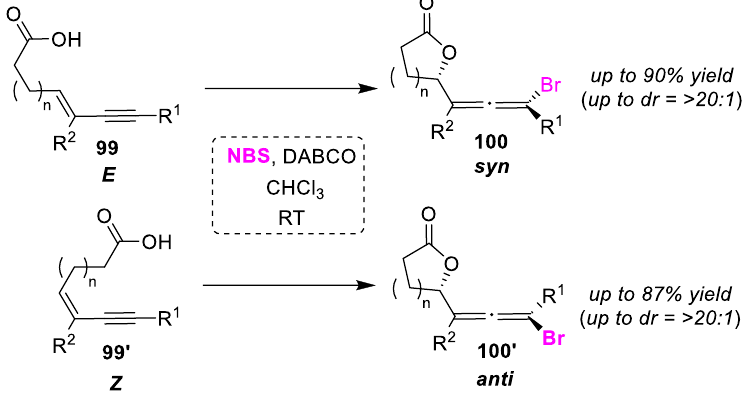
Figure 47. Stereoselective bromo-lactonizations of E - and Z -enynyl acids ( 99 and 9 9′ ) using DABCO.